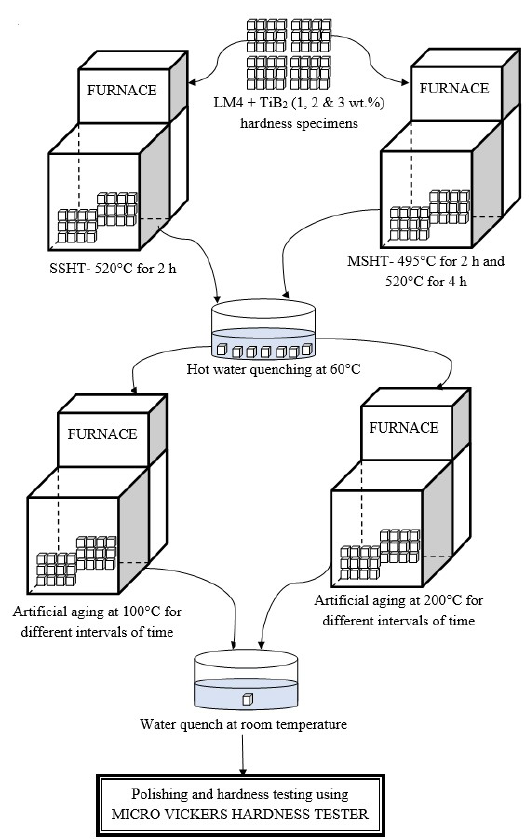
Figure 2. Schematic diagram of the age hardening treatment process carried out in present work.